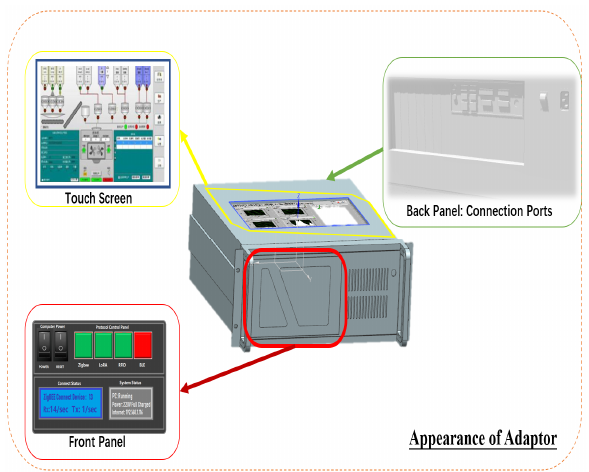
Figure 7. Appearance of GSW